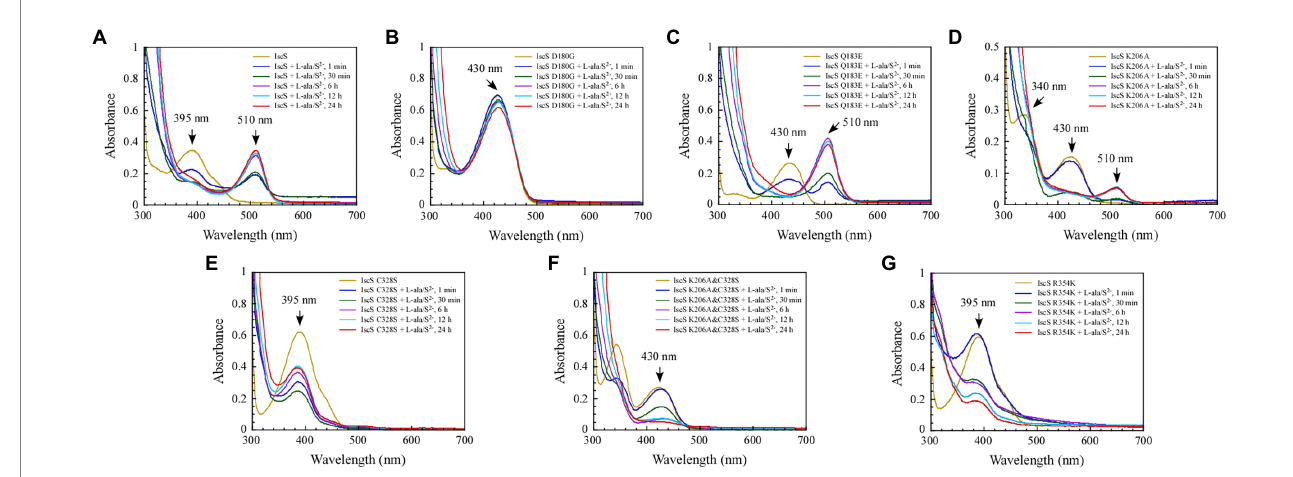
FIGURE 7 The formation of a red intermediate in wild-type IscS and IscS variants (Q183E, K206A) in vitro . (A–G) Purified IscS (100 μ M) and IscS variants (H104Q, D180G, Q183E, K206A, C328S, K206A&C328S, R354K; 100 μ M) were incubated with L-alanine (100 mM) and Na 2 S (100 mM) in Tris (120 mM, pH 8.0) buffer at